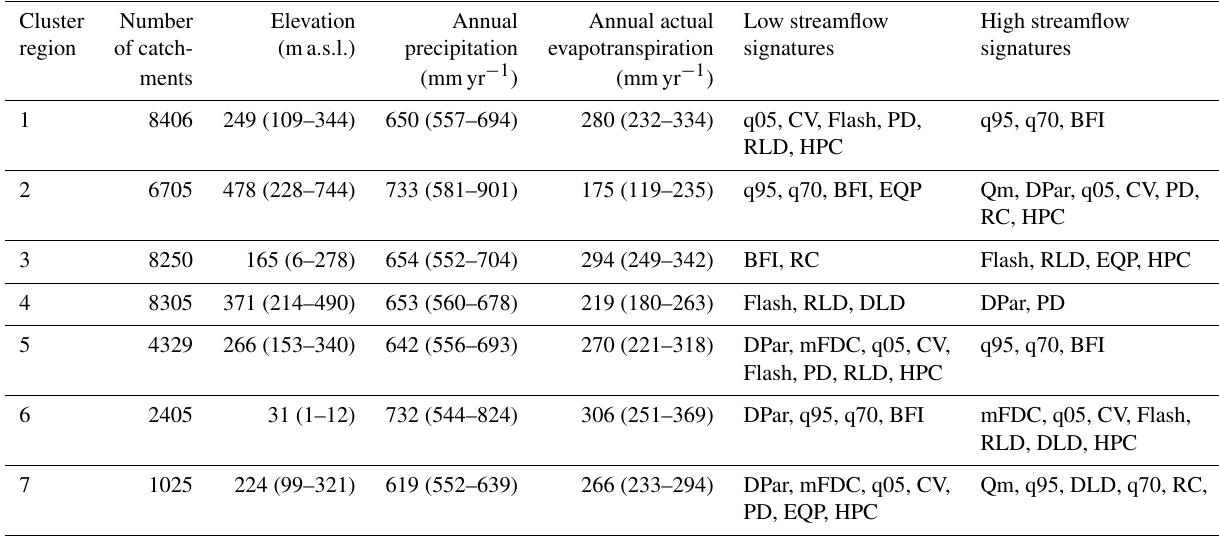
Table 2. Main characteristics of each of the hydrological clusters. The values provided for elevation, annual precipitation, and annual actual evapotranspiration correspond to the mean and interquartile range (25th–75th percentiles). Cluster Number Elevation Annual Annual actual Low streamflow High streamflow region of catch- (ma.s.l.) precipitation evapotranspiration signatures signatures ments (mmyr − 1 ) (mmyr − 1 )